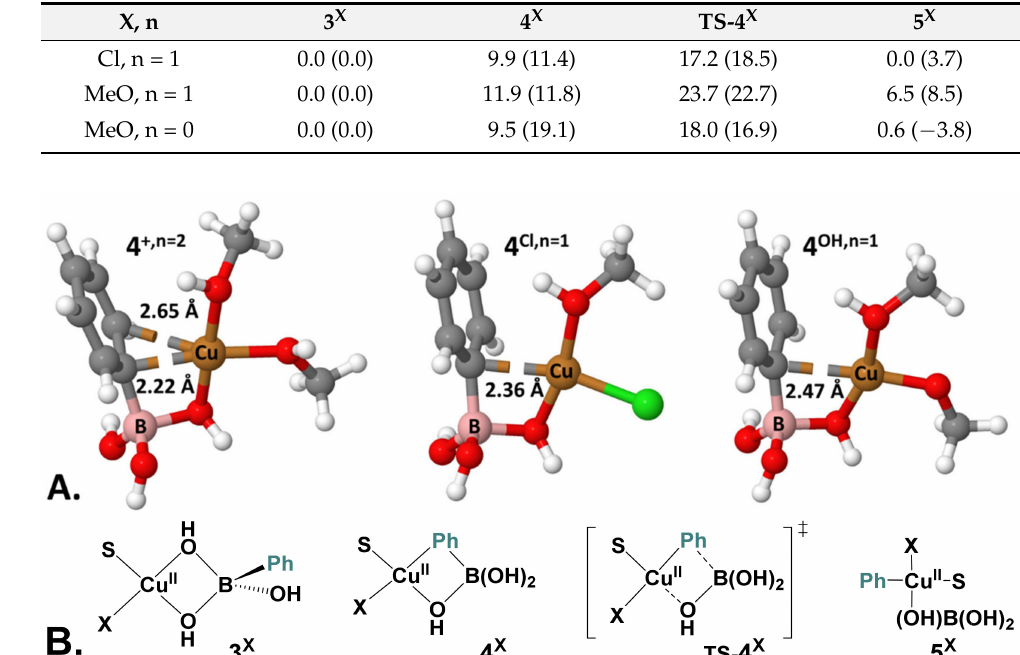
Figure 6. ( A ). 3D structures of optimized intermediates 4 X,n (X = +, Cl or MeO, n = 1 or 2). H in white, C in grey, O in red, B in pink, Cu in orange, and Cl in green. ( B ). Structures of intermediates and transition states involved in the B-to-Cu transmetalation (see Table 1 for the associated energies). See Figures S15 and S16 for alternative solvation